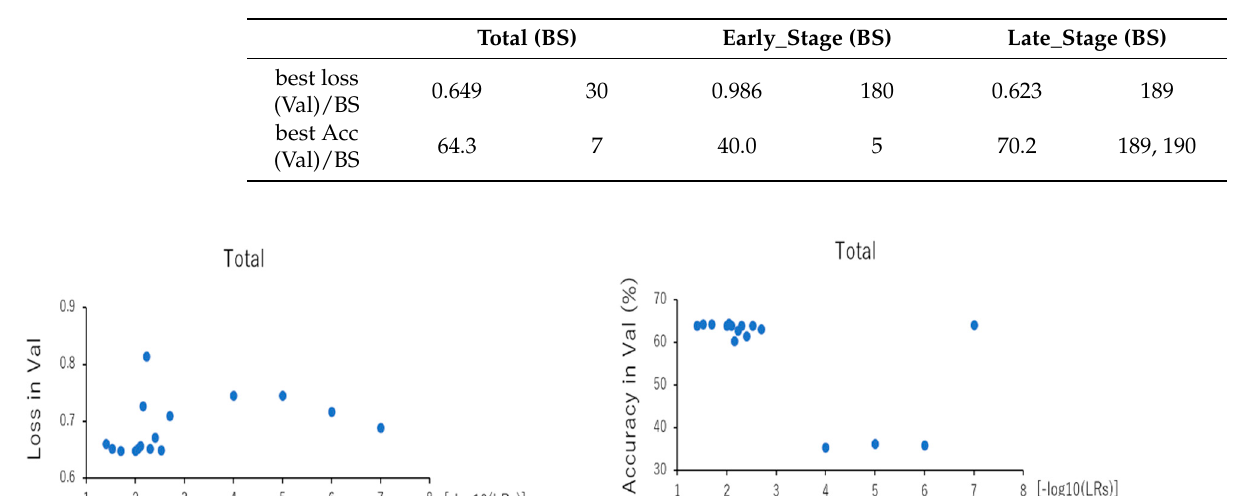
Table 3. Best loss(Val) and best Acc(Val) in total, early_stage, and late_stage datasets with BS.